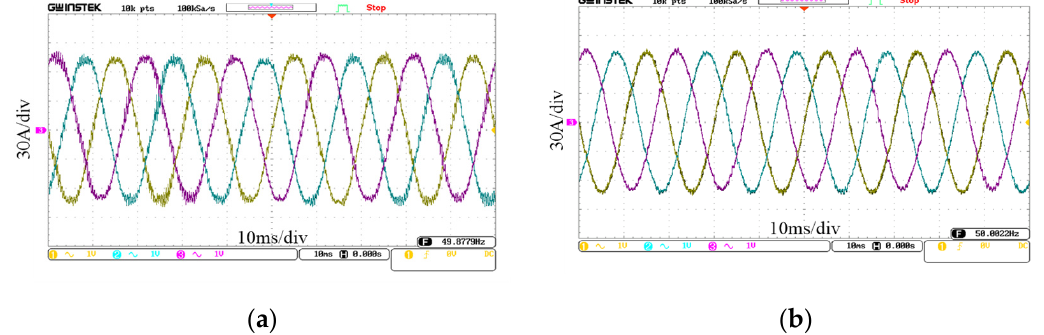
Figure 8. Experimental steady-state current waveforms: ( a ) Output current of the single closed-loop control experiment, ( b ) output current of the double closed-loop control experiment.